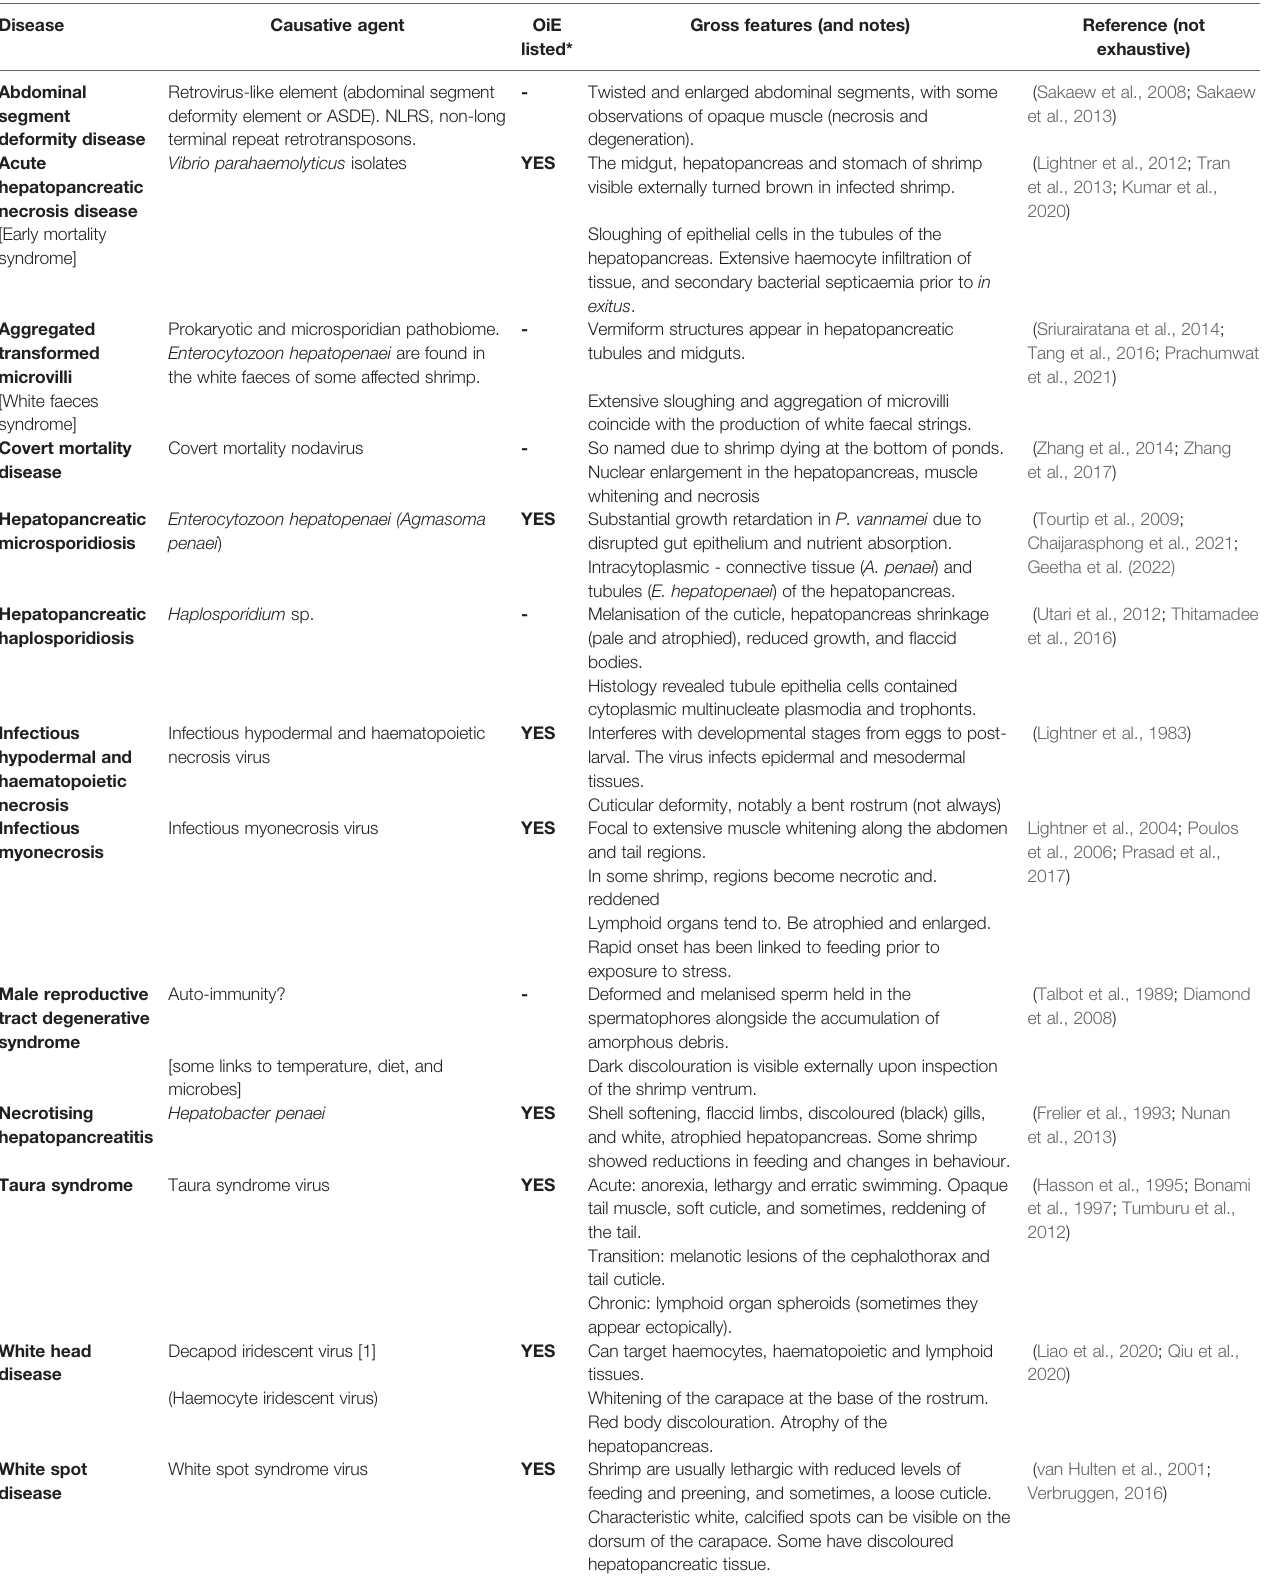
TABLE 2 | Marked infectious diseases and syndromes of cultured penaeid